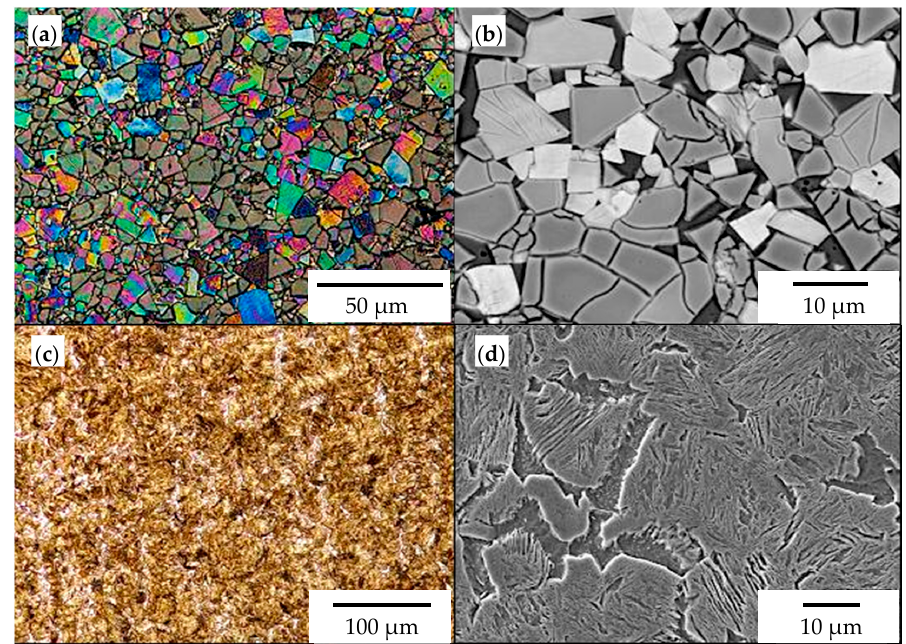
Figure 6. The microstructure of materials used for chisels A: ( a ) cemented-carbide plate (light microscope (LM)), ( b ) visible coarse grains of tungsten carbide in a cobalt matrix (SEM, back-scattered electron (BSE) detector), ( c ) microstructure of the base material (LM), and ( d ) visible medium-carbon martensite and ferrite (SEM, secondary electron (SE) detector).